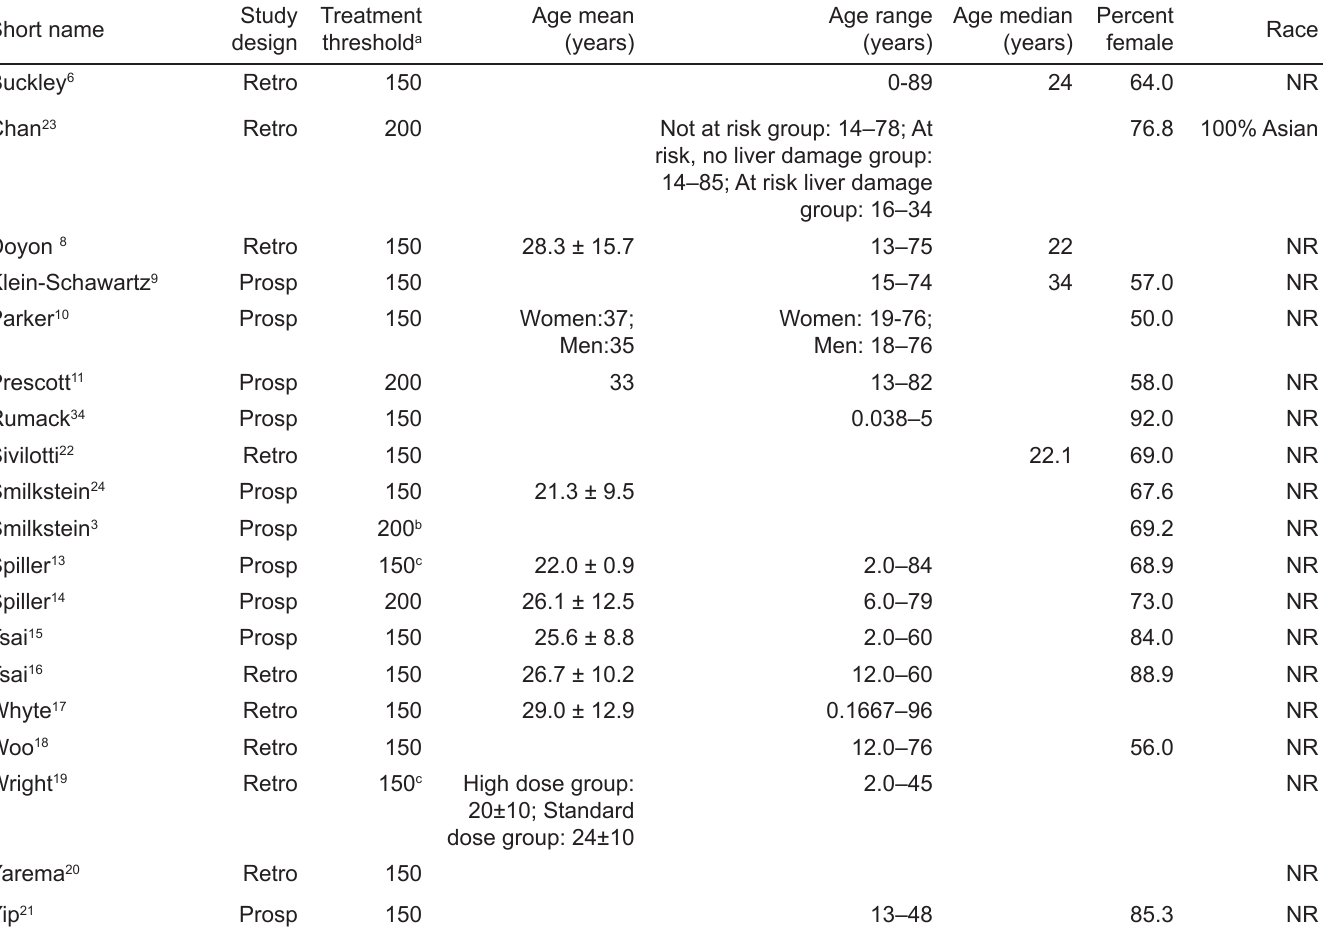
Table 1 . Demographics and study characteristics for citations reporting ≥ 20